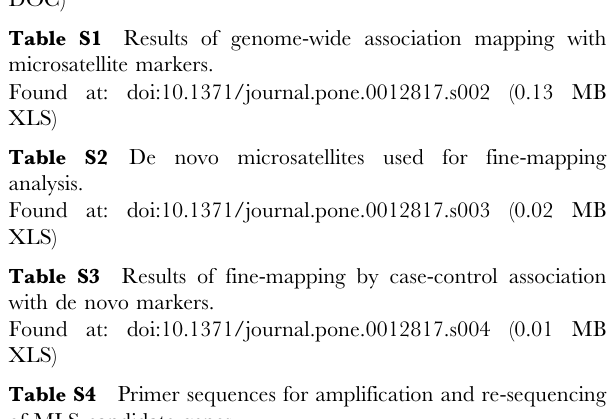
Table S4 Primer sequences for amplification and re-sequencing of MLS candidate